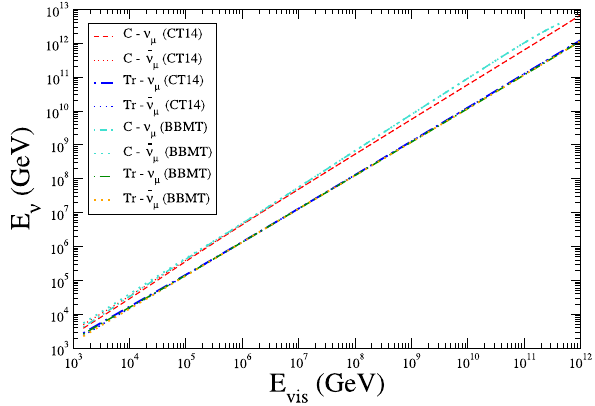
Fig. 5 The impact of the average inelasticity in the relation between the incoming neutrino energy and the visible energy in the detector for the (anti)muon neutrino case. The label C ( Tr ) refers to cascades ( muon tracks )